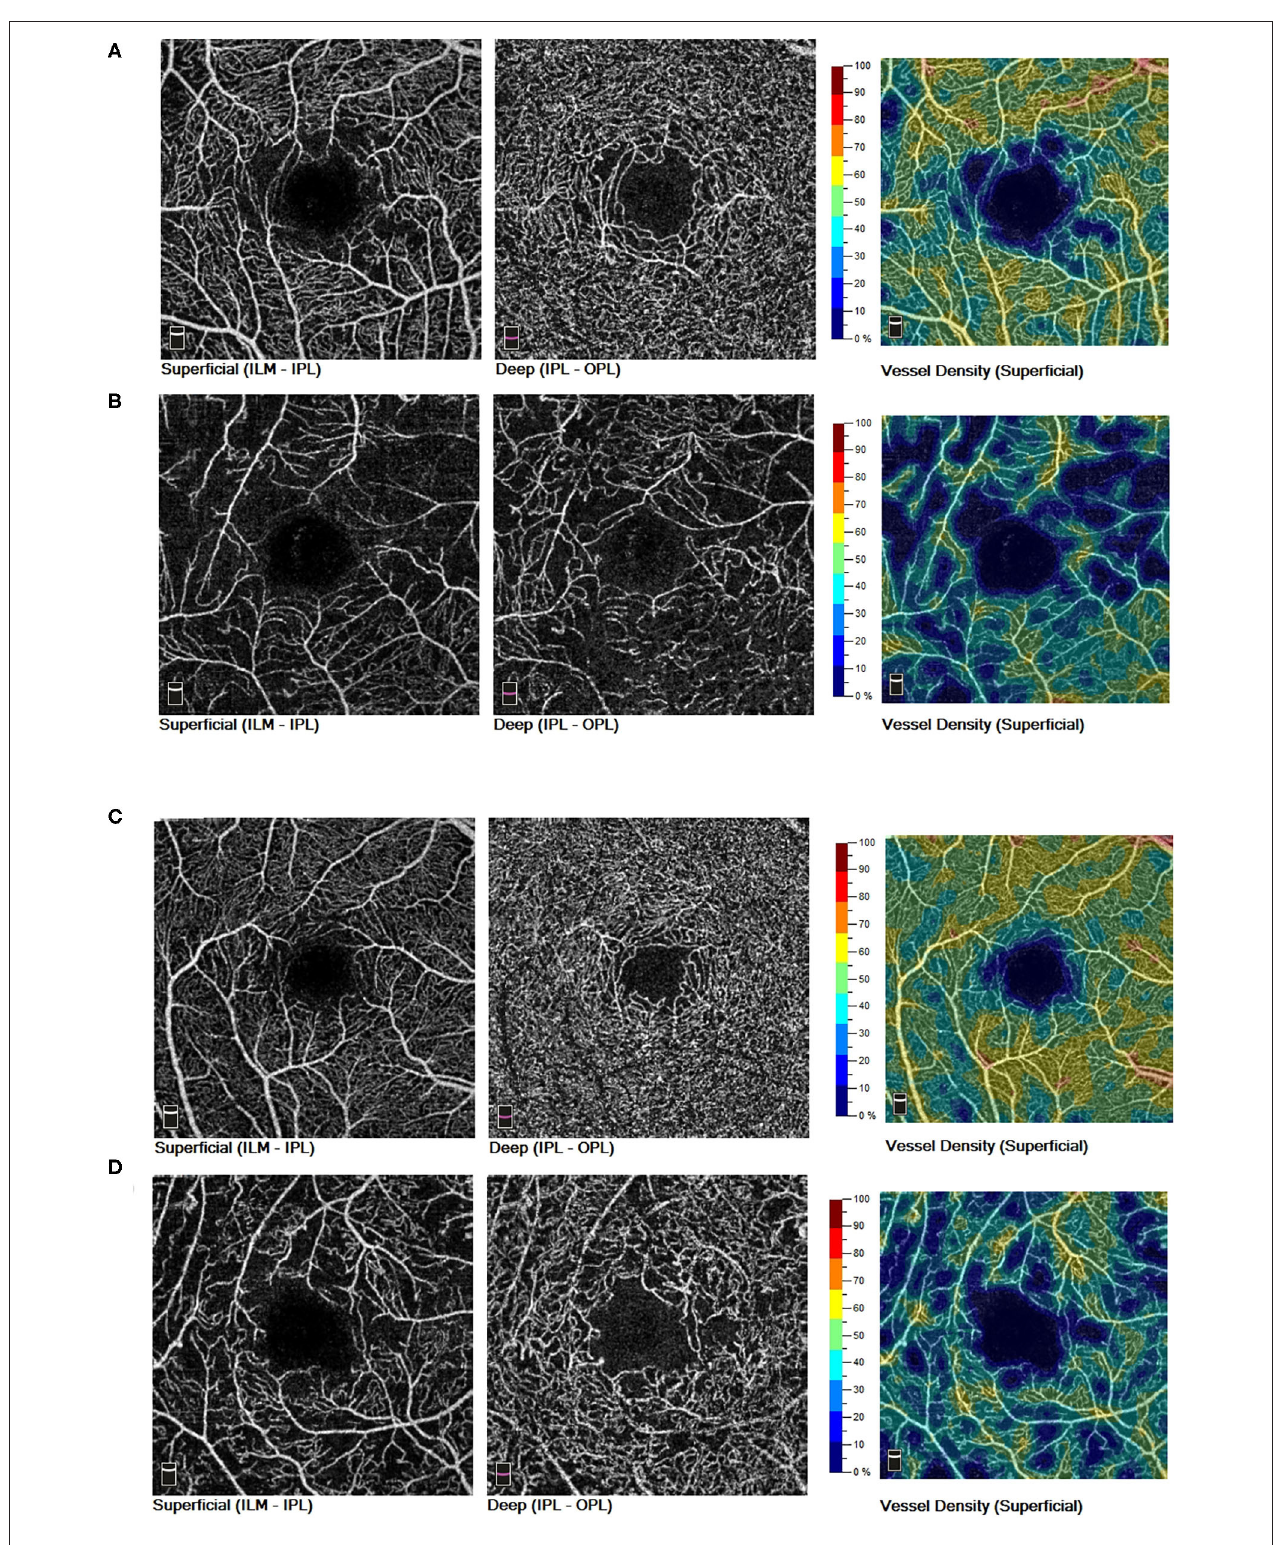
FIGURE 3 | In non-myopic eyes of diabetic patients, both SVD and DVD showed decreased trend from NoDR eyes (A) to DR eyes (B) . In myopic eyes of diabetic patients, only SVD demonstrated a decreased trend from NoDR eyes (C) to DR eyes (D) . SVD, superficial vessel density; DVD, deep vessel density; NoDR, diabetes without diabetic retinopathy; DR, diabetic